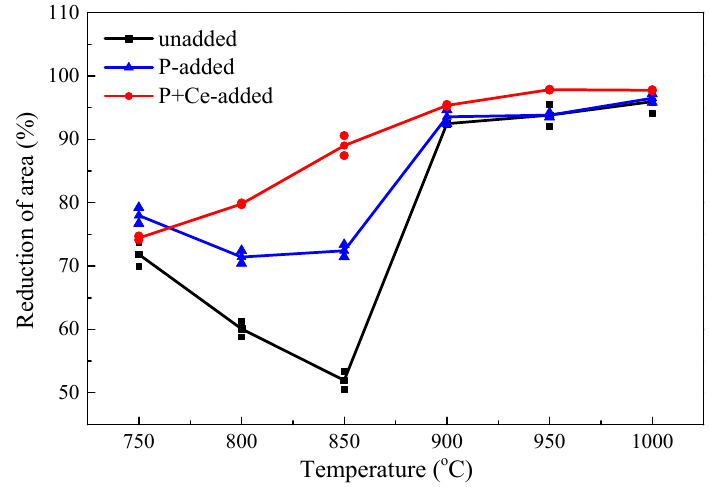
Figure 1. Hot ductility curves for the unadded, P ‐ added, and P+Ce ‐ added steels.